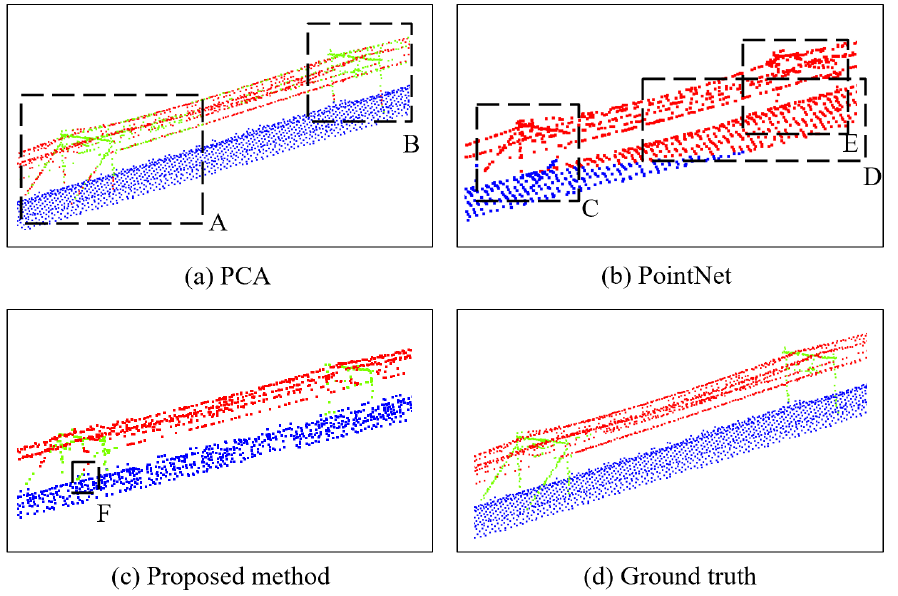
Figure 17. The results of different wire segmentation methods. The wire, pylon, and ground are colored with red, green, and blue, respectively. The black dotted frame indicates points that are classified with error.